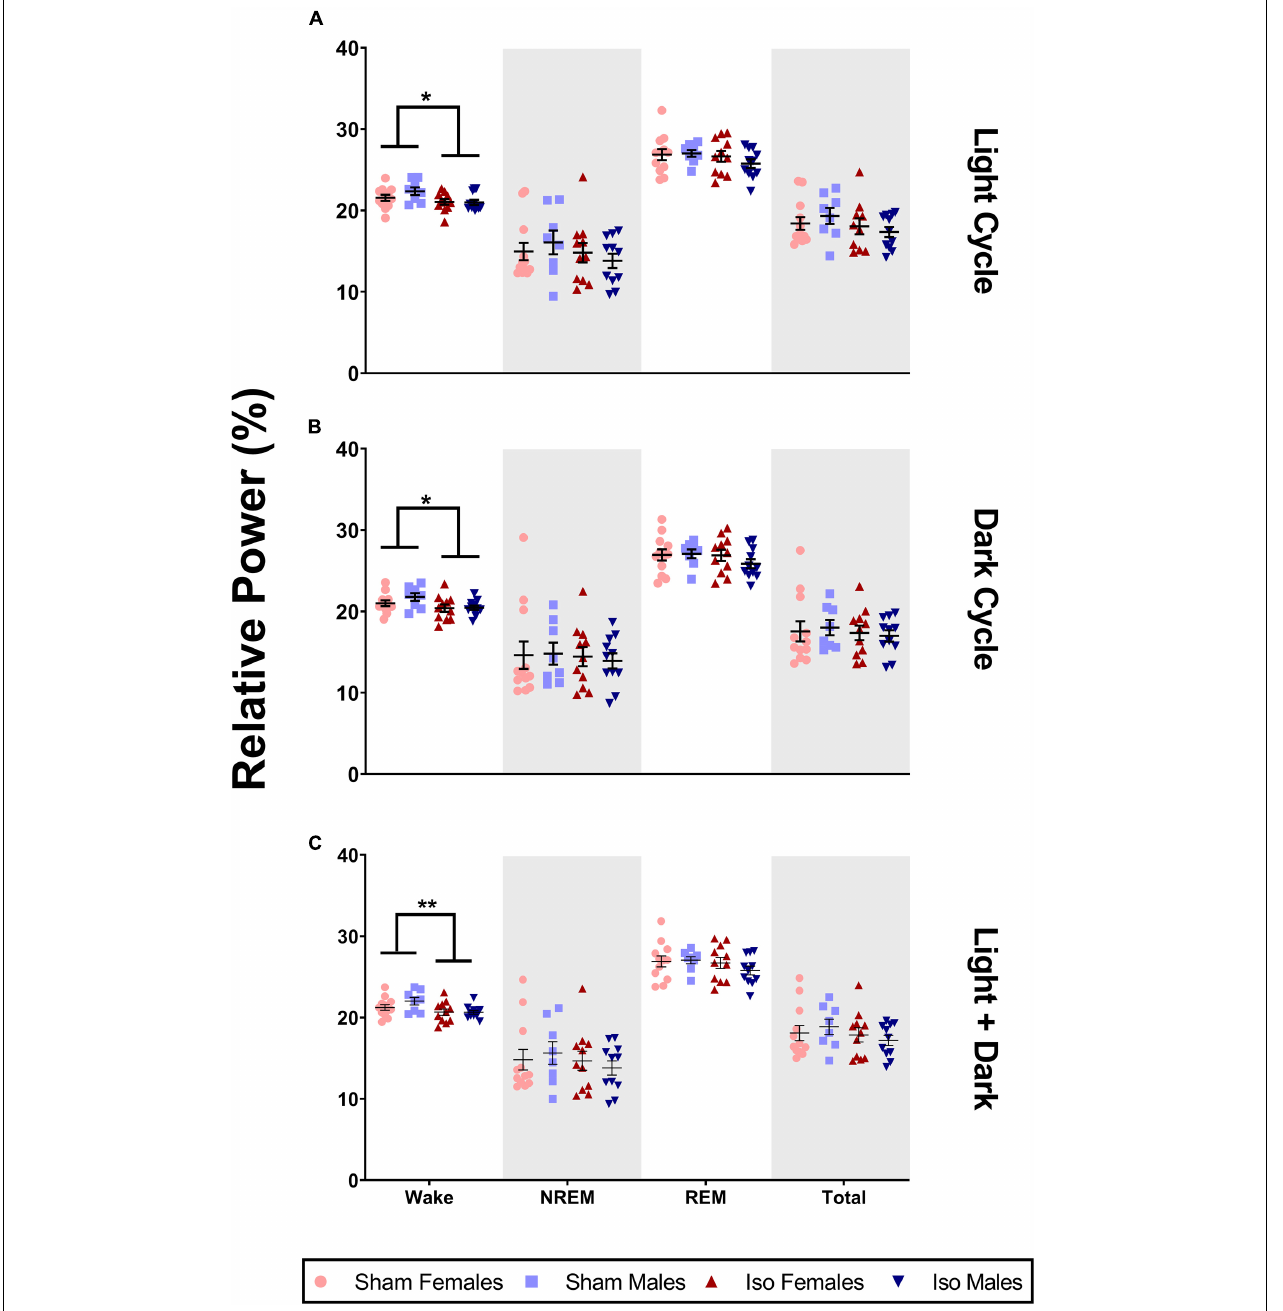
FIGURE 5 | Neonatal isoflurane exposure resulted in a minimal but significant decrease in power spectra in the beta frequency band. (A) During the light cycle, there was a decrease in wake beta power in animals exposed to Iso (* P = 0.018). However, there were no changes in beta during NREM ( P = 0.222), REM ( P = 0.293), or across total recording period ( P = 0.188). (B) There was also a decrease in wake beta power in Iso exposed rats during the dark cycle (* P = 0.018). But, there were no changes in beta power during NREM ( P = 0.694), REM ( P = 0.335), or total recording period ( P = 0.547). (C) Finally, decreases in beta during wake were also observed when both cycles were combined (** P = 0.010), and these changes were not seen during NREM ( P = 0.420), REM ( P = 0.252), or total recording period ( P =